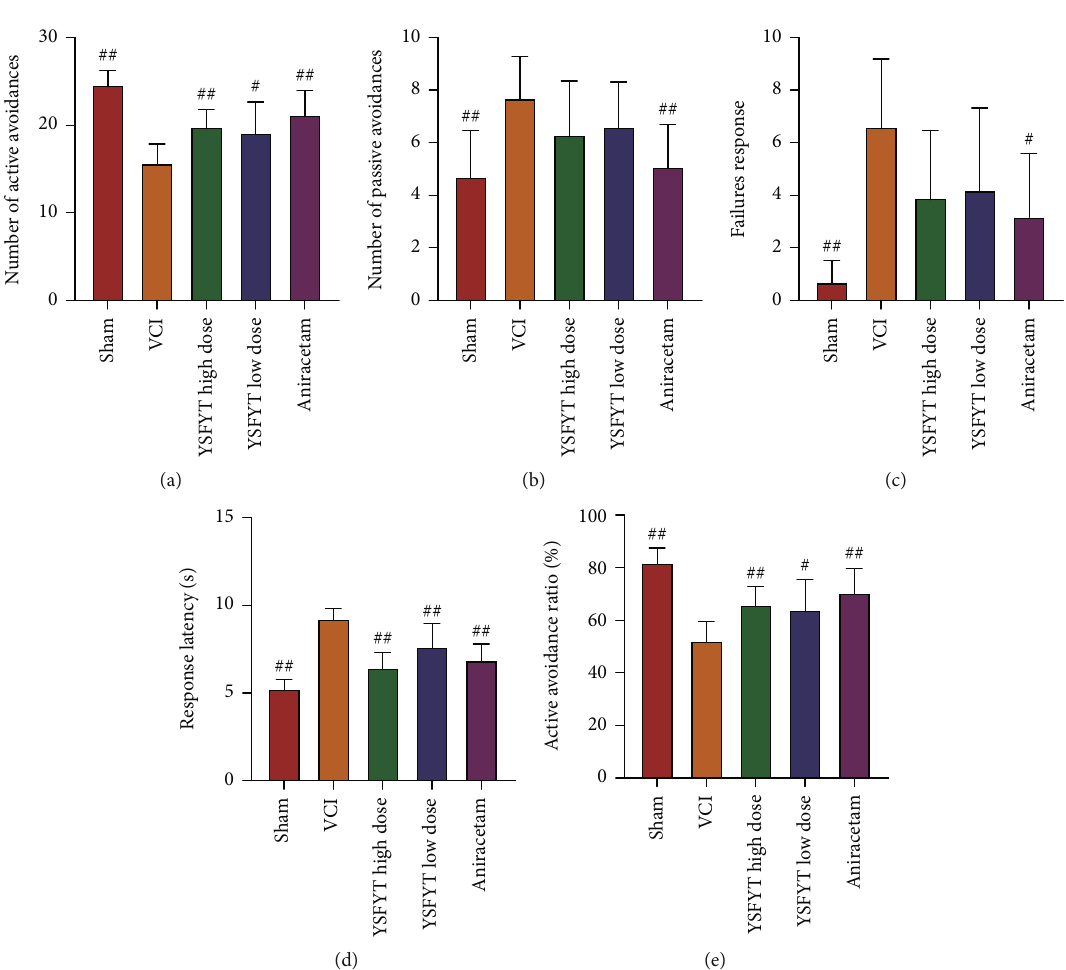
Figure 3: Shuttle box experiment results. (a) Number of active avoidance. (b) Number of passive avoidance. (c) Escape response failures. (d) Response latency. (e) Proportion of active avoidance. # p < 0 : 05 ; ## p < 0 : 01